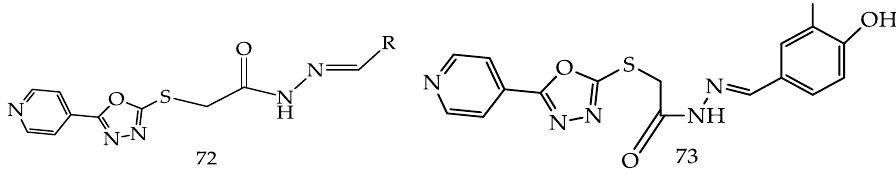
Figure 16. The chemical structure of pyridine and acylhydrazone bearing 1,3,4-oxadiazole moiety .